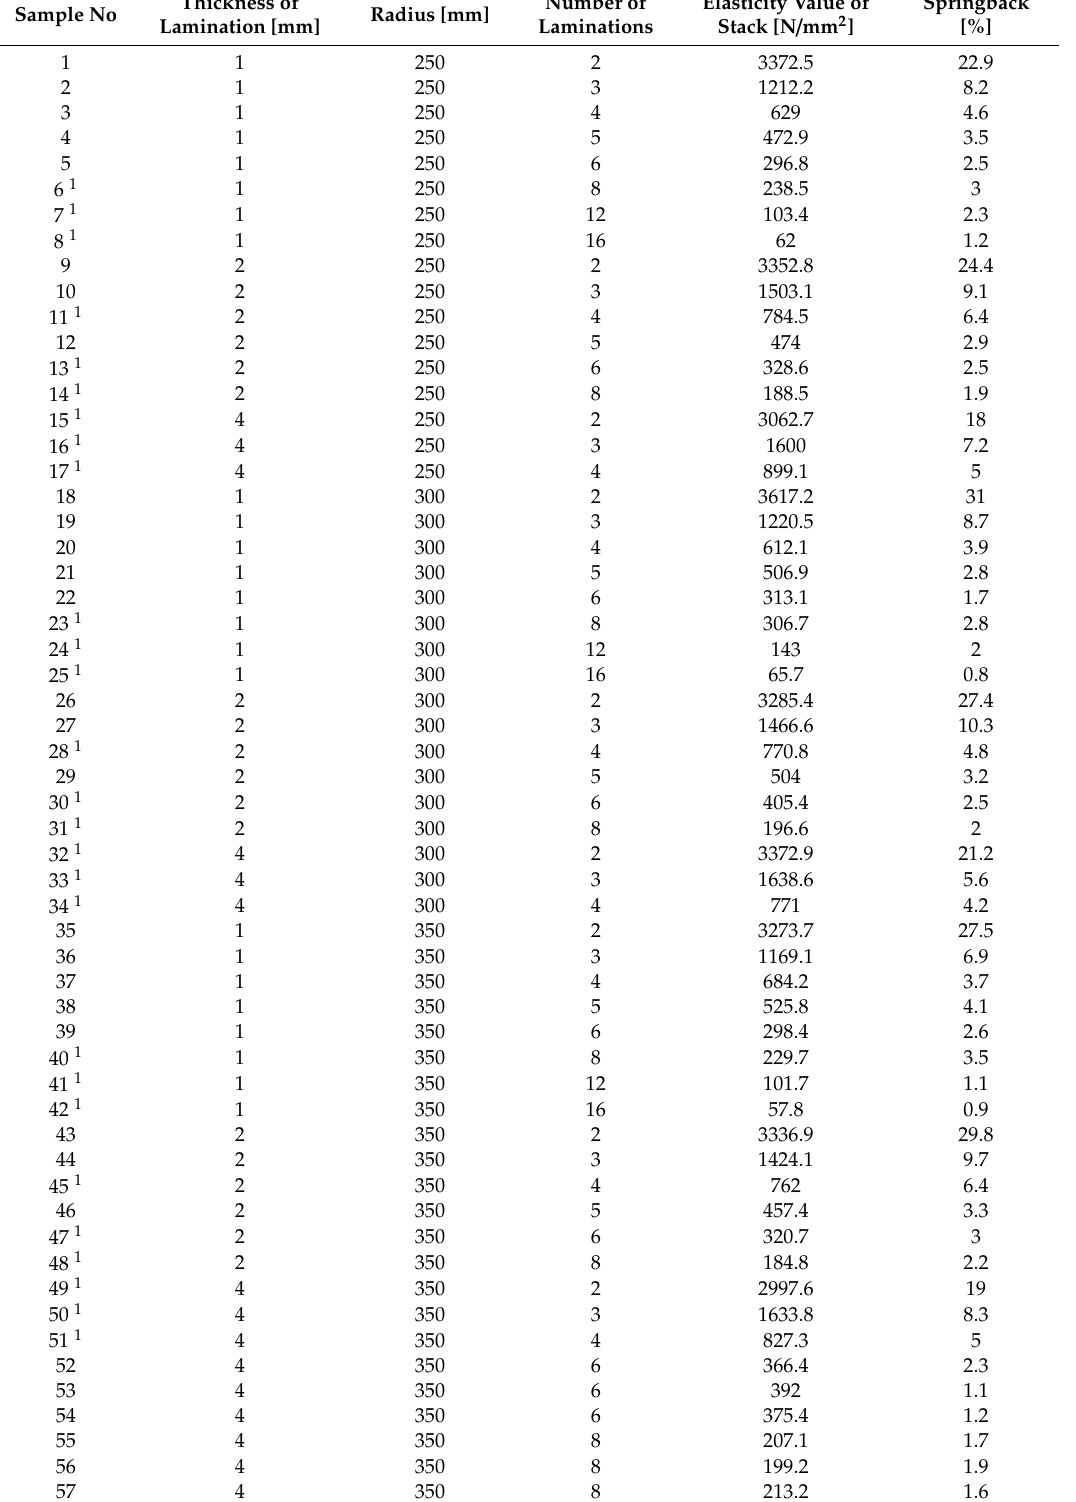
Table 1. Springback values [%] and elasticity value of the stack [N / mm 2 ] sorted by their lamination and stack thickness [mm] as well as the number of laminations. The three radii are present in all combinations of lamination thickness and number of laminations except samples